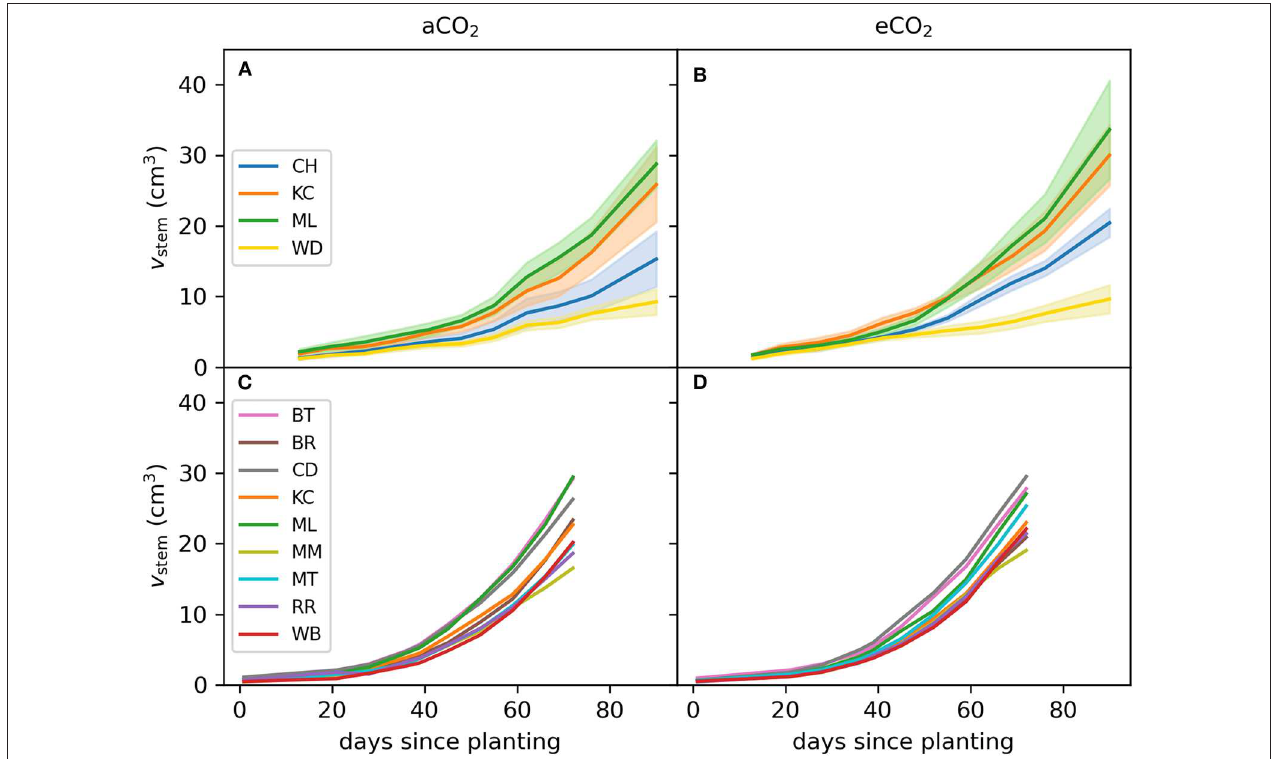
FIGURE 5 | Stem volume of E. grandis during Experiment 1 and 2. Seedlings ( n = 3–7 per provenance) were grown in ambient (aCO 2 ; left ) and ambient [CO 2 ] (eCO 2 ; right ). Colors in (A,B) represent the four selected provenances of Experiment 1. The nine selected provenances of Experiment 2 are shown in (C,D) . Shaded bands represent